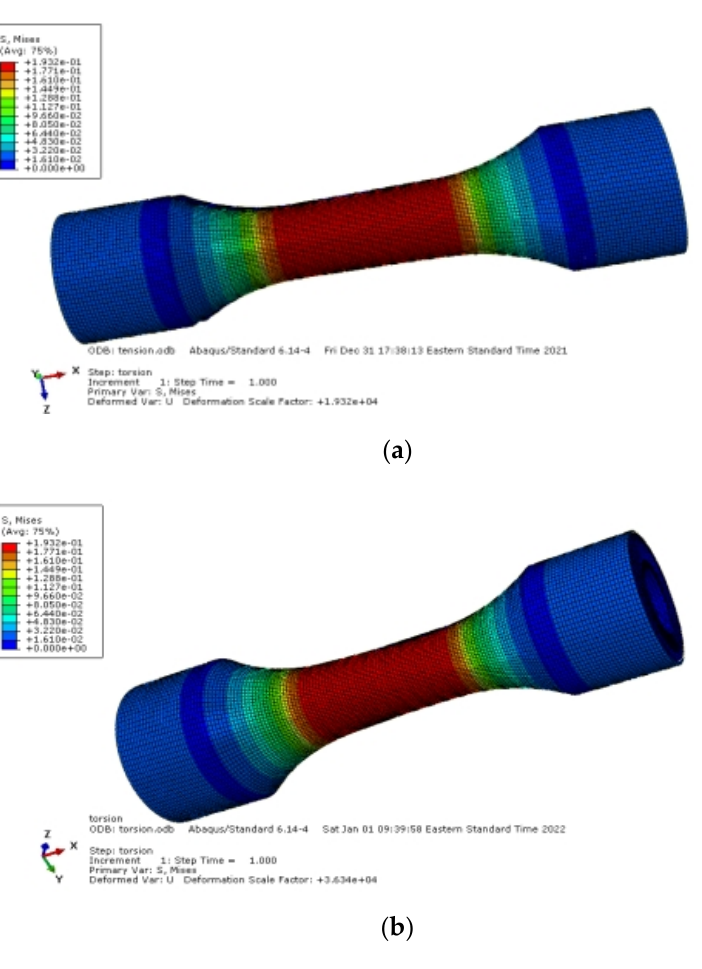
Figure 21. Procedure of the modeling. The local model is based on aluminum with approximate grain sizes of 6–7 ASTM GS. The square is 50 × 50 A0. ( a ) Under tension loading. ( b ) Under torsion loading.